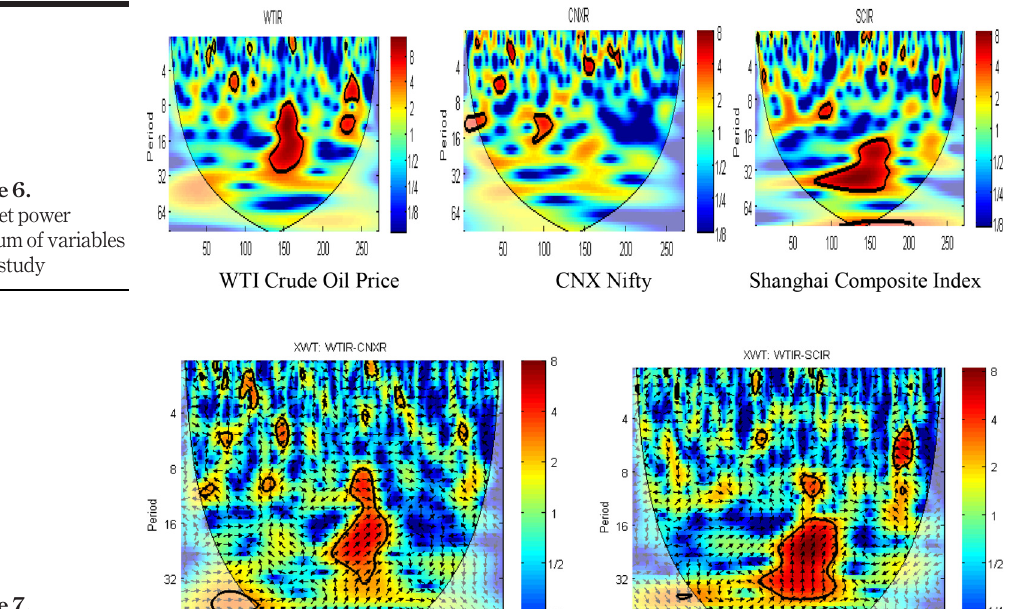
Figure 7. XWT between WTI crude oil prices and stock indices of India and China